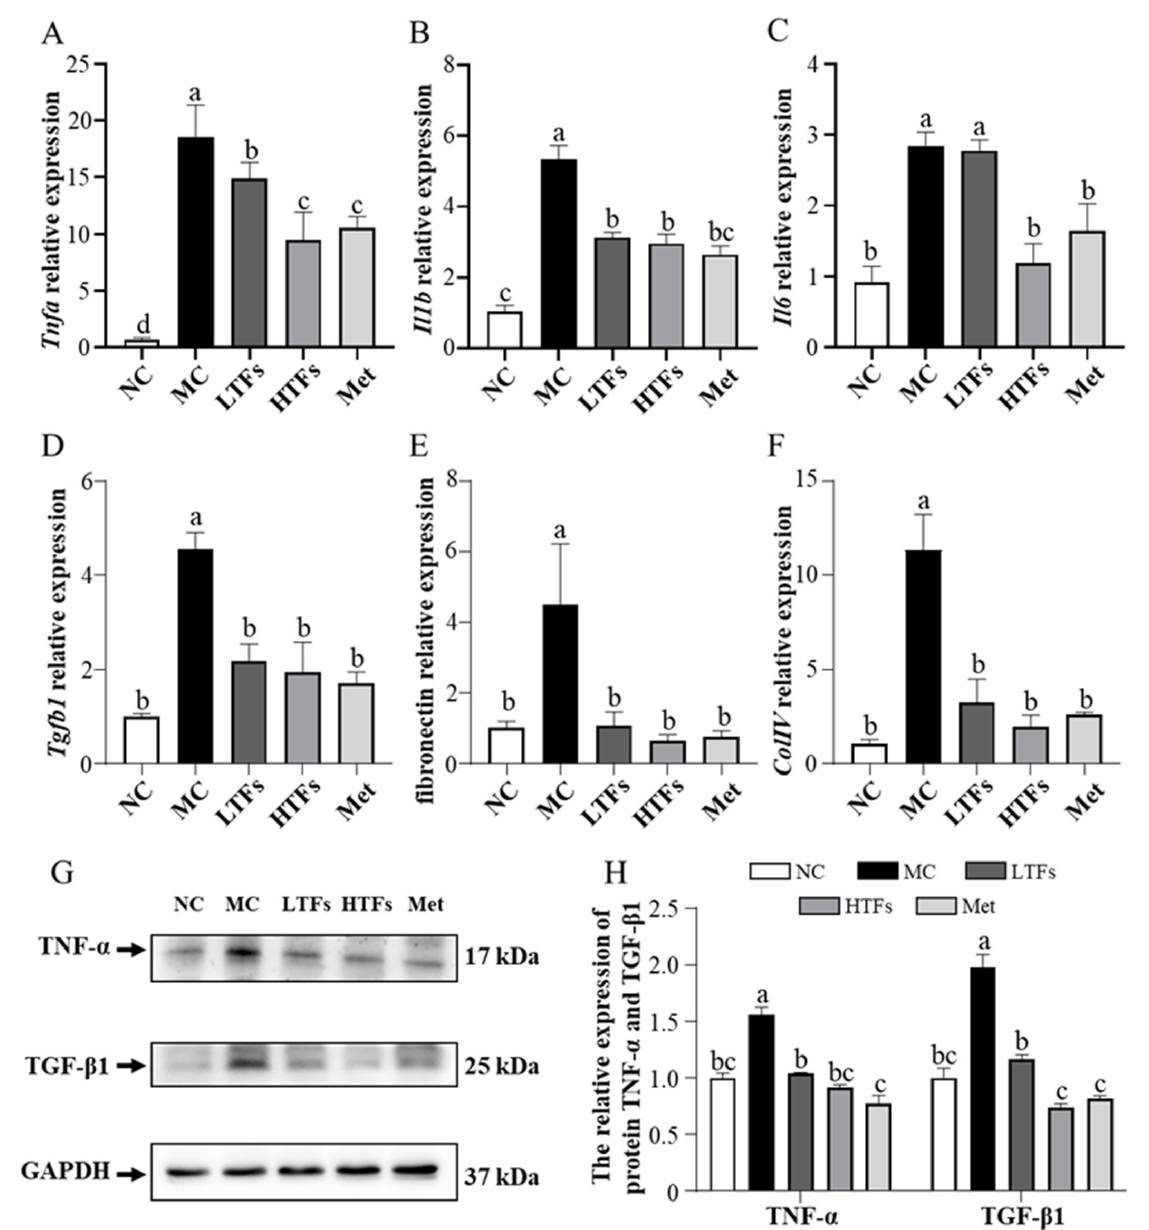
Figure 5. Inflammation and fibrosis in the kidney tissues of T2DM mice. The mRNA expression of inflammatory markers: Tnfa ( A ), Il1b ( B ), and Il6 ( C ); the mRNA expression of fibrosis markers: Tgfb1 ( D ), fibronectin ( E ), and ColIV ( F ); ( G ) Western blot analysis of TNF- α and TGF- β 1; ( H ) quantification of TNF- α and TGF- β 1 protein expression. NC: normal control; MC: diabetic model control; LTFs: low-dose TFs; HTFs: high-dose TFs; Met: metformin. Each value represents the mean ± SEM ( n = 6). Values with different letters (a–c) differ from each other significantly ( p < 0.05).